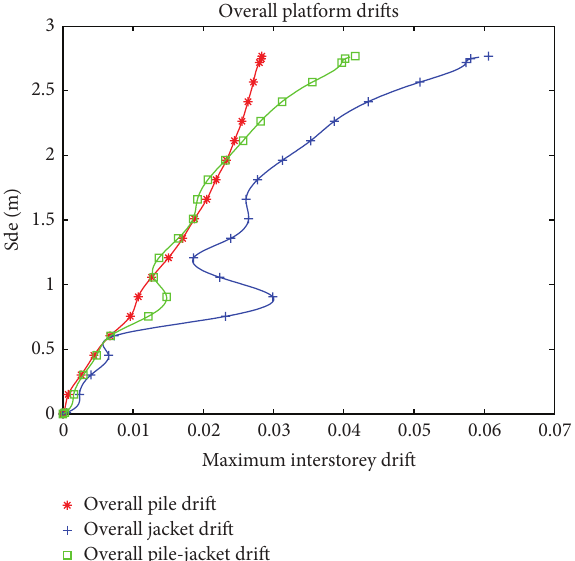
Figure 14: The overall platform drift ratios.